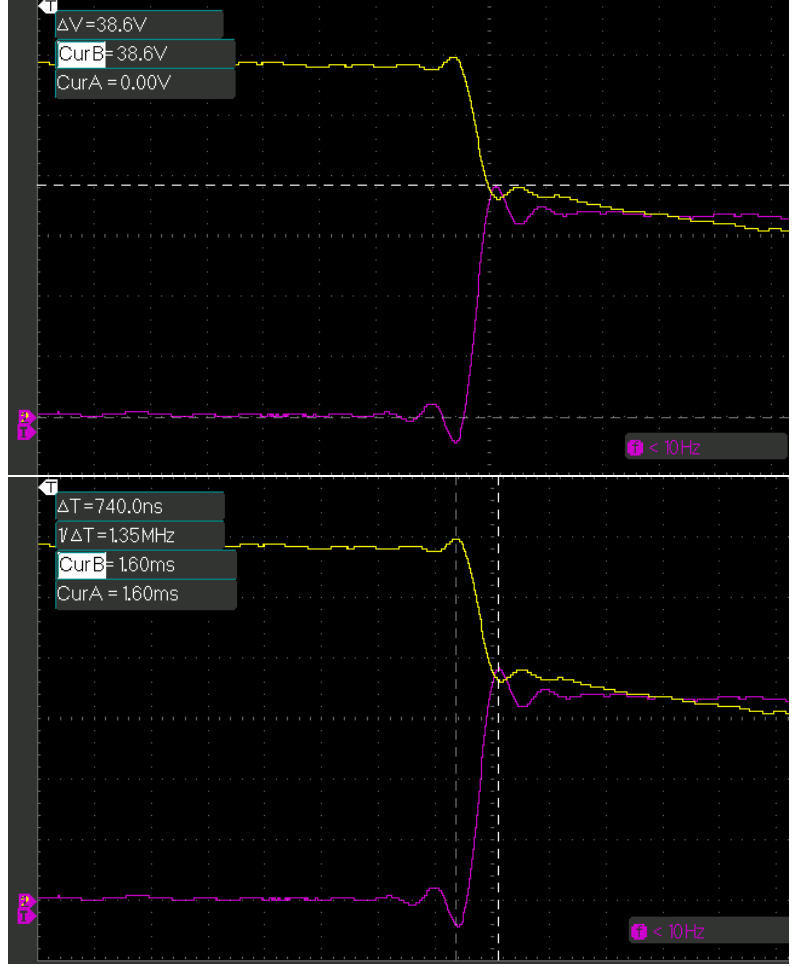
Figure 17. U ZS 1 = 60 V turn-off